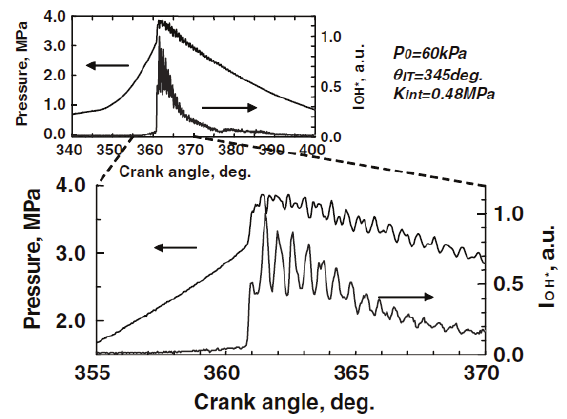
Fig. 2. Oscillation of the hydroxyl radical emission intensity – I OH• with the in-cylinder pressure [19]